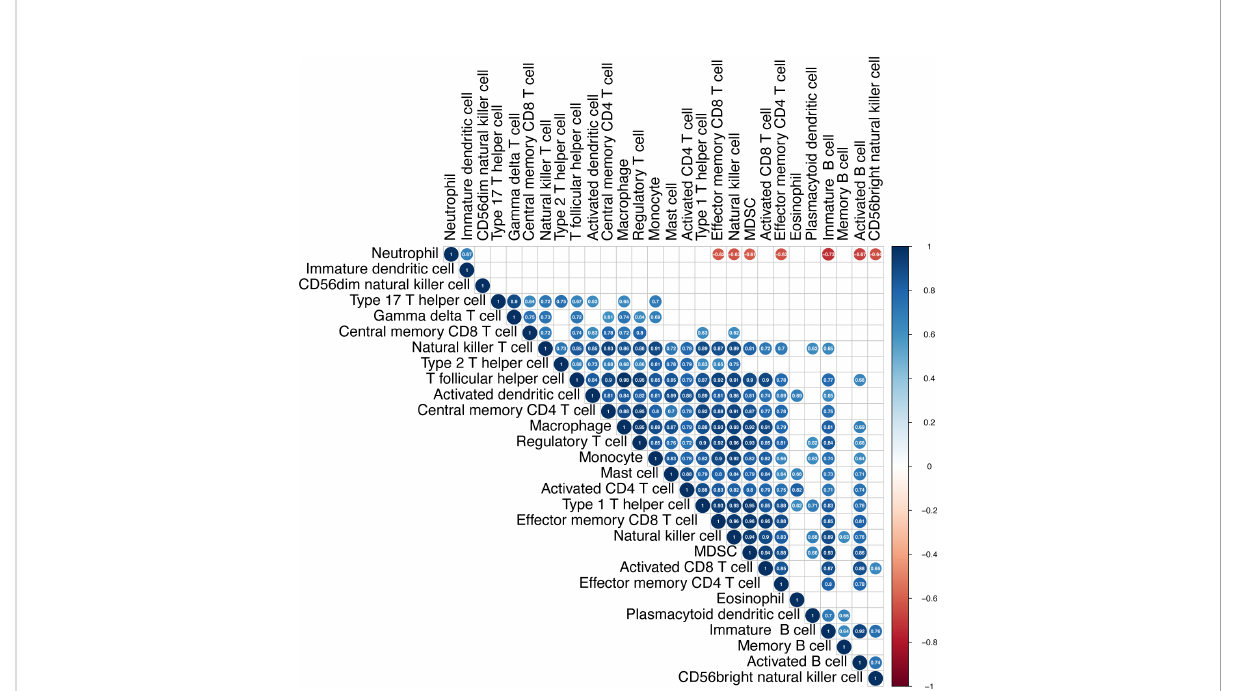
FIGURE 4 In fi ltration of immune cells in PCP tumor. The heatmap shows correlations between the 28 immune cell subtypes. The strength of the correlation is indicated by a heatmap colored from red to blue. The numbers in each cell indicate the Pearson coef fi cients, while blank cells present the non-statistically signi fi cant